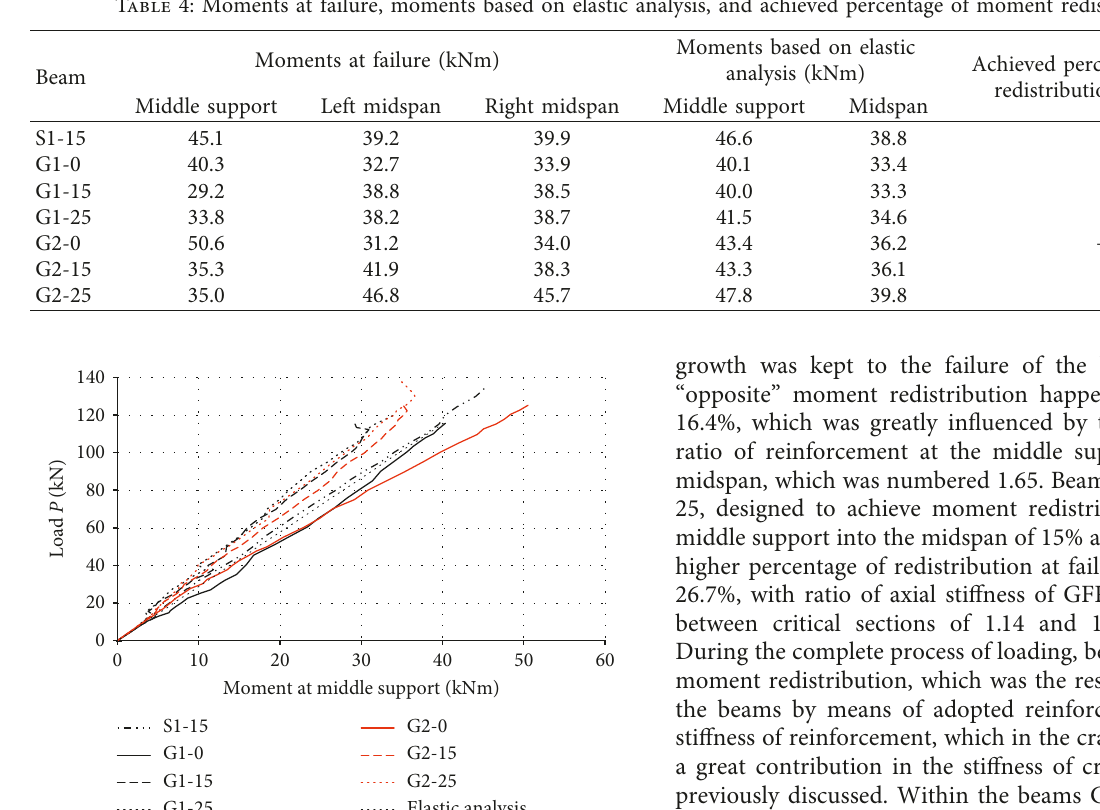
Figure 9: Load-moment relationship at the middle support for tested beams.